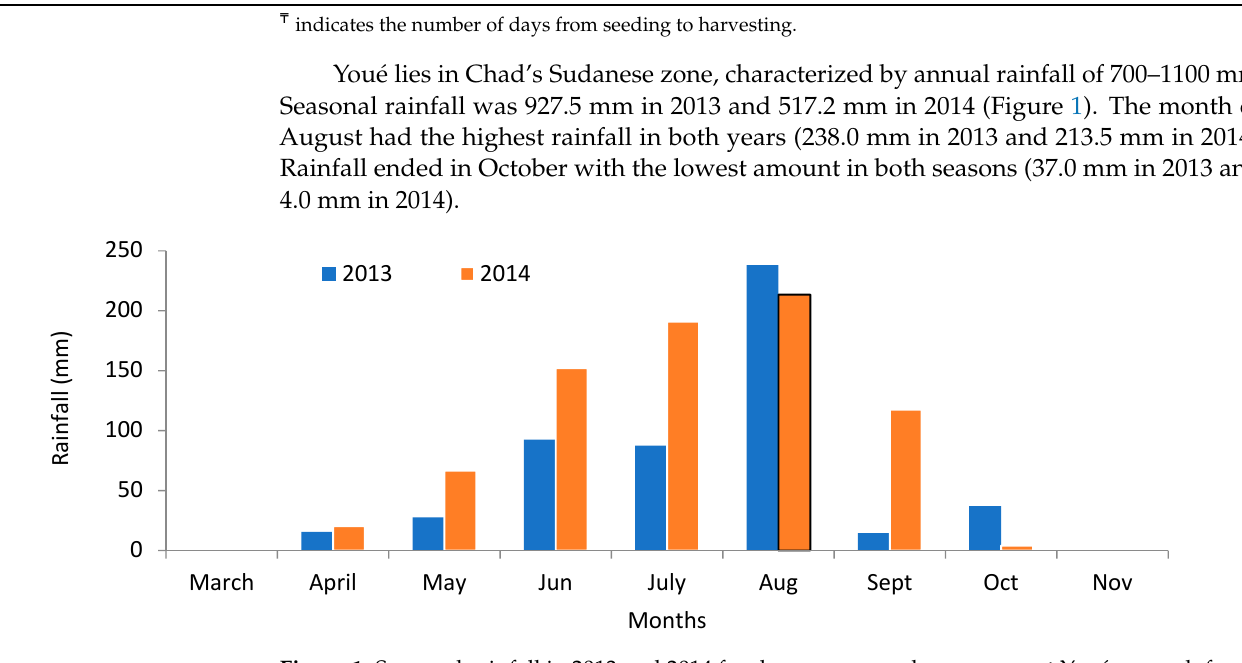
Figure 1. Seasonal rainfall in 2013 and 2014 for dry-season sorghum grown at Youé research farms in Chad.